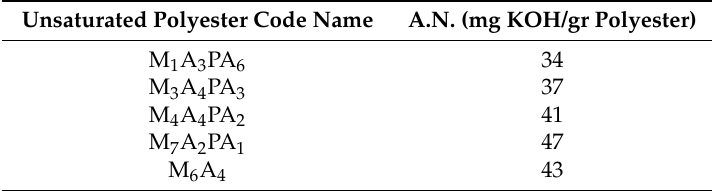
Table 2. The Acid Number of each laboratory synthesized unsaturated polyester.